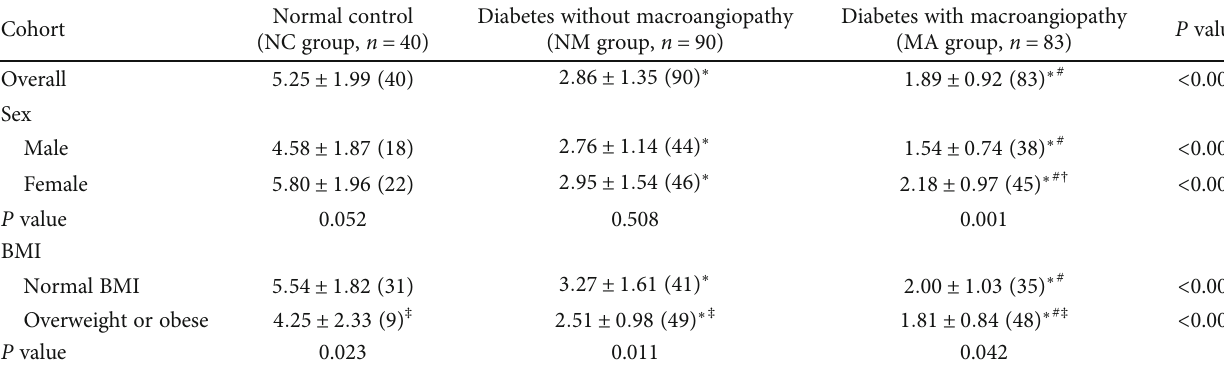
Table 2: Comparison of serum adiponectin levels after sex and BMI strati fi